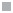
Effect of Sb on lipid peroxidation (A) and, on the superoxide production (B), SOD (C), POX (D), APX (E), GR (F), DHAR (G), and GSNOR (H) activities in roots (□) and leaves (■) of H. annuus plants. Data from 5 independent experiments, each one carried out in triplicate (different letters indicate significant differences at p<0.05, Mann-Whitney U-test).